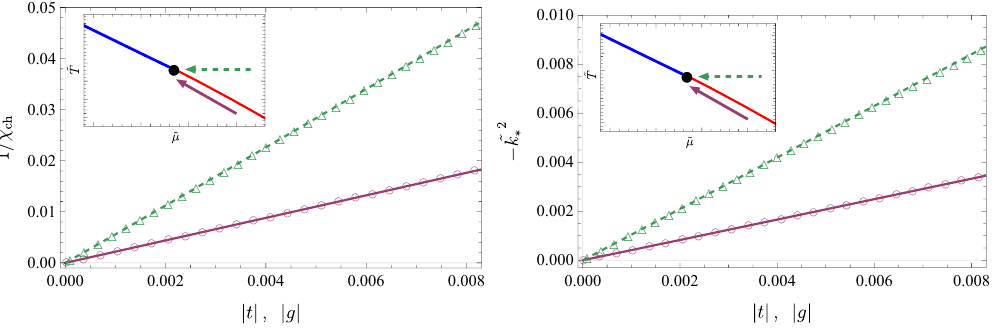
(right panel) along the λ -line (open ∗